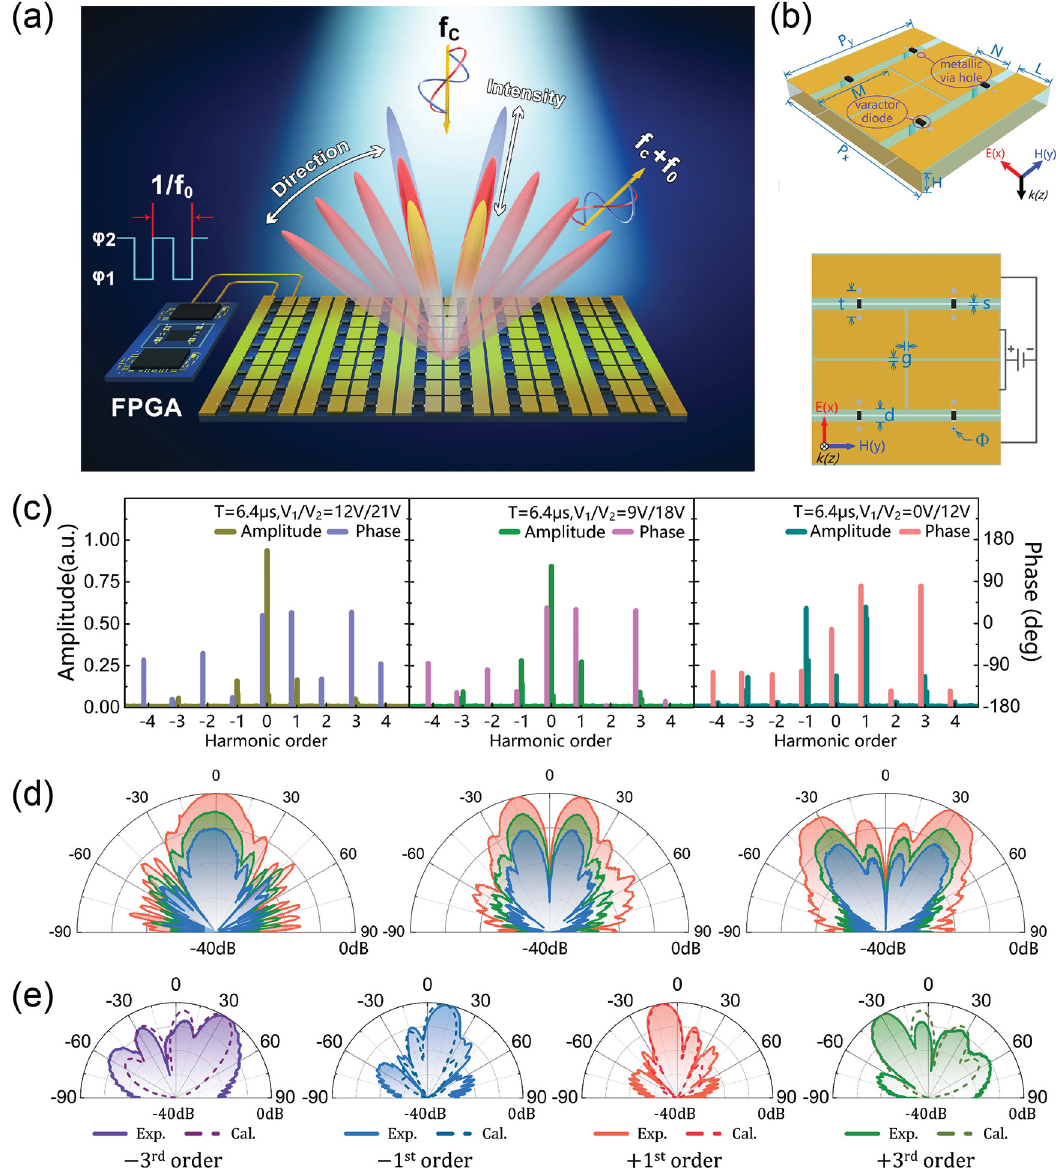
Fig. 6. Independent control of harmonic amplitudes and phases (adapted from [31]). (a) Conceptual illustration. (b) Schematic of the coding element featuring four varactor diodes. (c) Measured amplitudes and phases at various harmonic orders, for different combinations of the biasing voltages. (d) Measured scattering patterns at the harmonic order +1, for three different spatial codings; patterns of different colors illustrate the possibility to independently control the amplitude by acting on the temporal coding. (e) Representative examples of multi-order harmonic tailoring of the scattering patterns (measured and